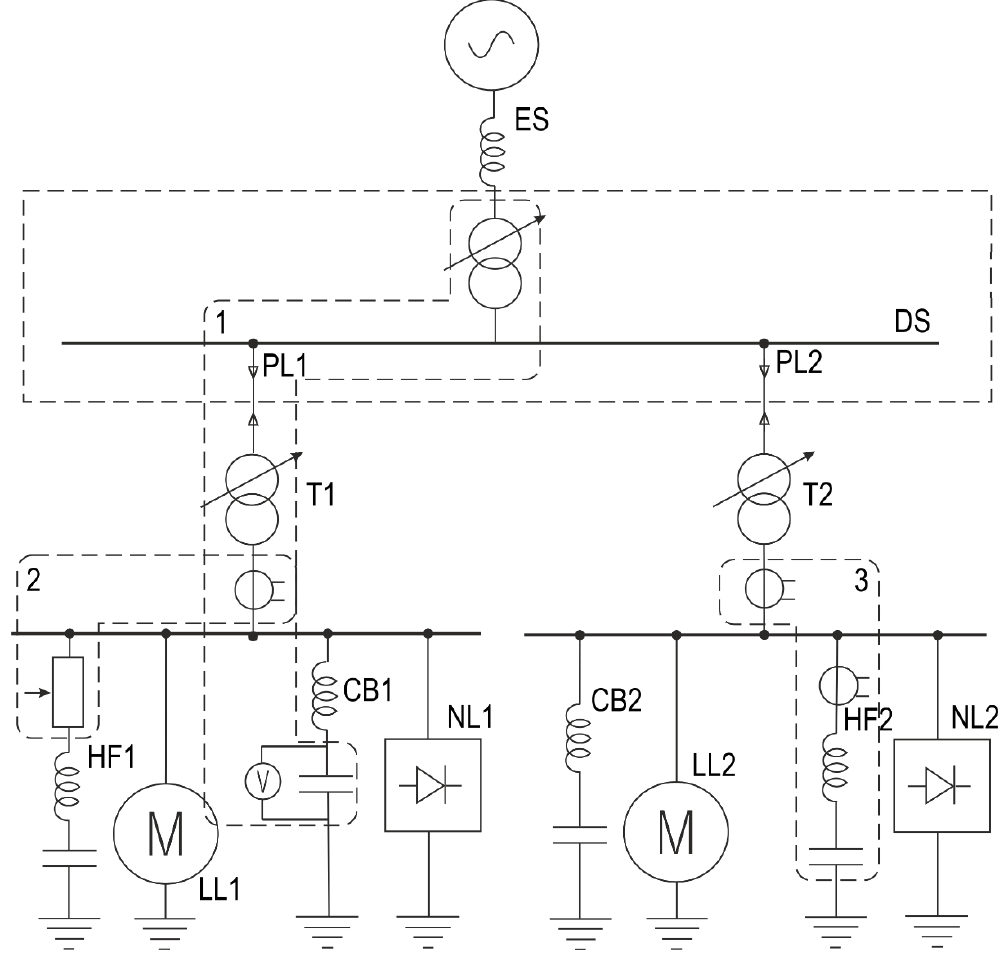
Figure 4. The structural scheme of the electrical grid under study.